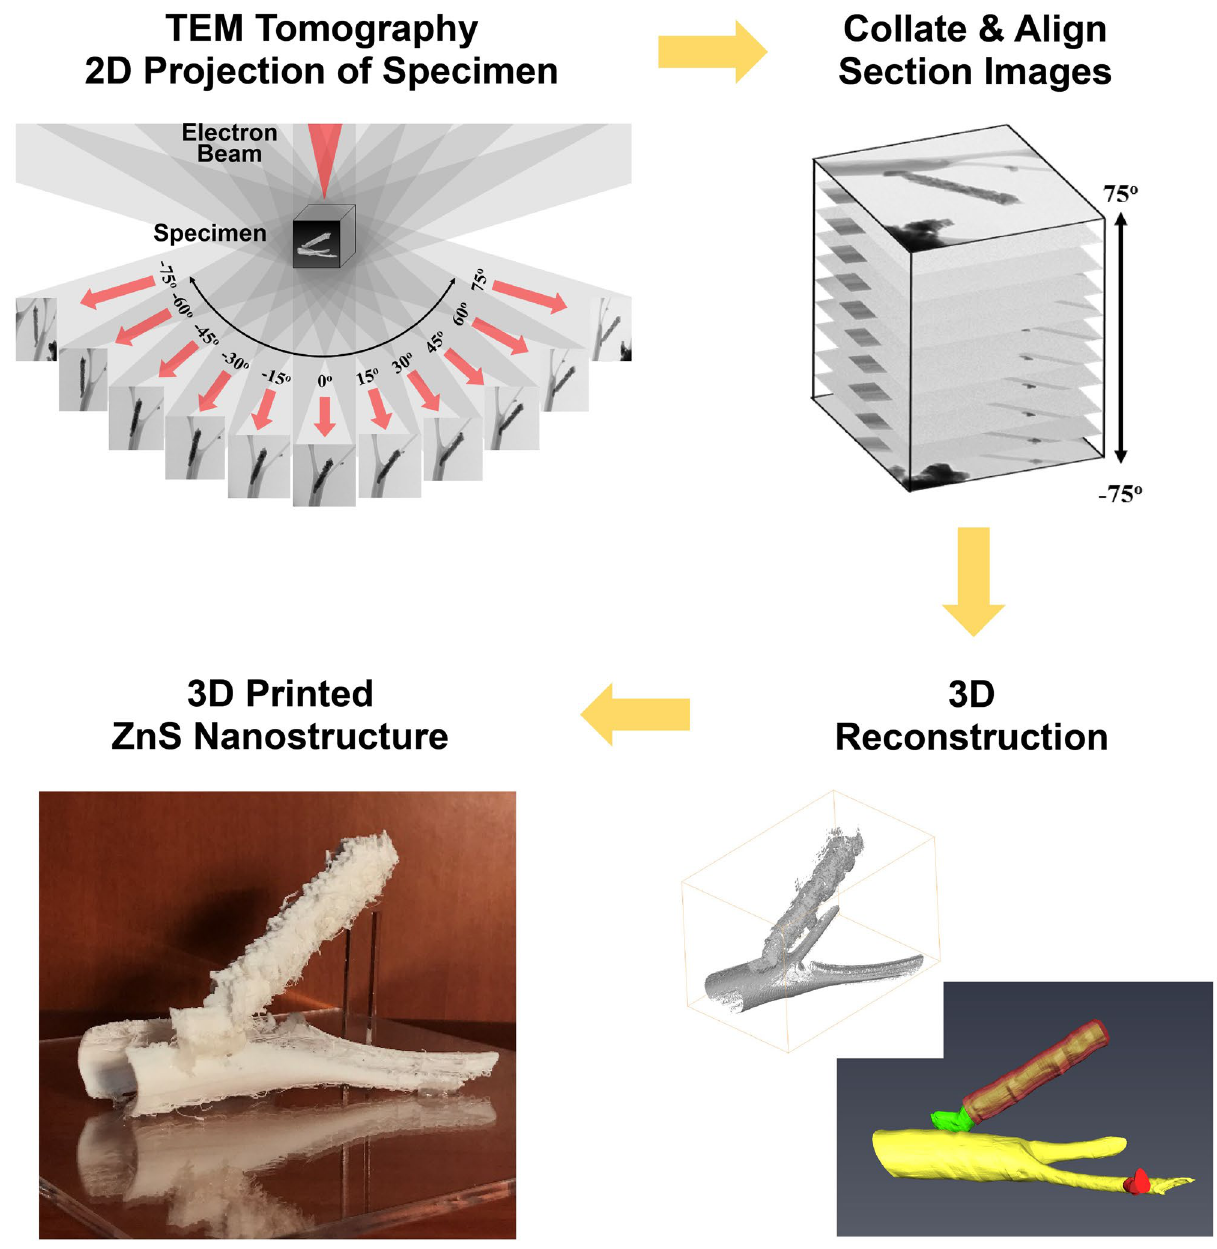
Figure 3. Schematic illustration of TEM tomography data acquisition, 3D reconstruction, and 3D printing